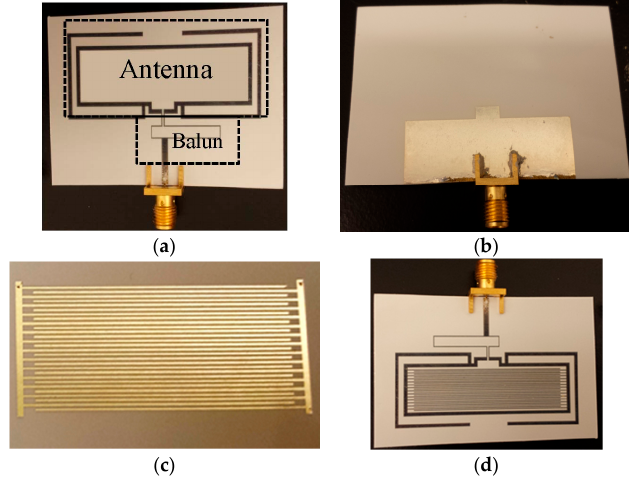
Figure 5. Fabricated prototypes. ( a ) Top view of antenna; ( b ) Bottom view of antenna; ( c ) Inkjet-printed interdigitated electrode; ( d ) Complete prototype with antenna, balun, and interdigitated electrode.